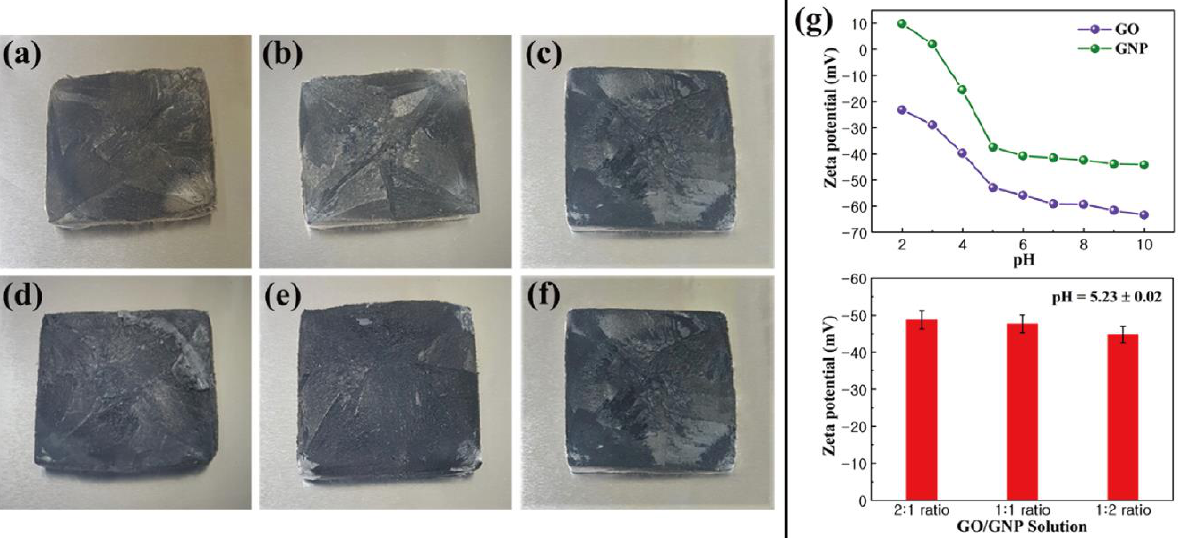
Figure 2. Photographs of graphene oxide (GO) aerogel and graphene nano-platelet (GNP): ( a ) 2:1 ratio GO/GNP aerogel, ( b ) 1:1 ratio GO/GNP aerogel, ( c ) 1:2 ratio GO/GNP aerogel, ( d ) 2:1 ratio rGO/GNP aerogel, ( e ) 1:1 ratio rGO/GNP aerogel and ( f ) 1:2 ratio rGO/GNP aerogel. ( g ) Zeta potential values of GO and GNP in the range of 2–10 pH.